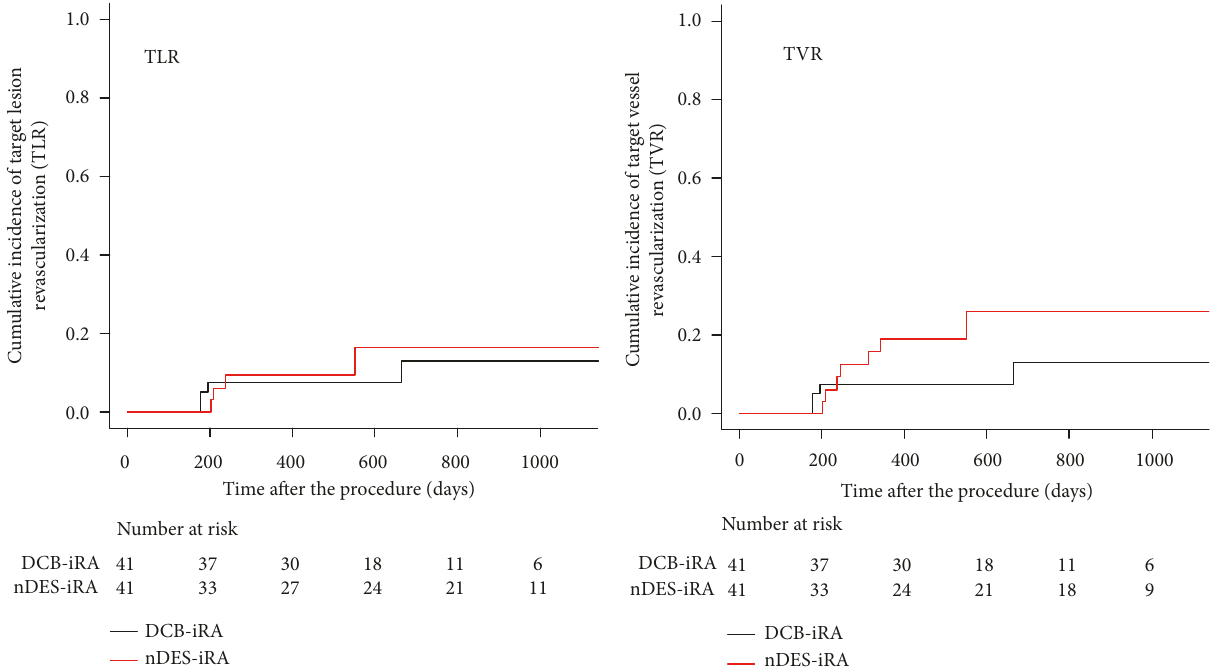
Figure 2: Cumulative Kaplan–Meier estimates of the incidence of target lesion revascularization (TLR) (left panel) and target vessel revascularization (TVR) (right panel), using the propensity matched cohorts of 41 lesions treated with drug-coated balloons (DCB) after intravascular image-guided rotational atherectomy (iRA) (DCB-iRA) and 41 lesions treated with new generation drug-eluting stents (nDES) after iRA